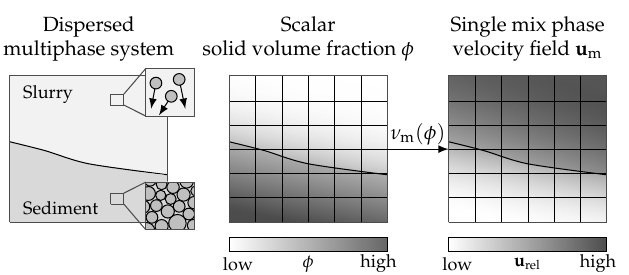
Figure 1. Schematic representation of the transport equation of the dispersed phase and its influence on the flow conditions based on Hammerich [32]: The two-phase system consisting of particles and liquid has been described as an incompressible mixed phase. The solids volume fraction allows the division of the simulation geometry into two different regions, slurry and sediment. Both differ in terms of their rheological behavior, which is taken into account via the